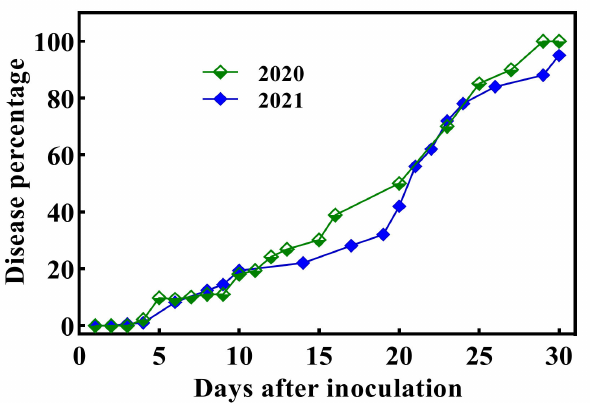
Figure 3. Dynamics of wheat canopy disease variation at different days after inoculation in both wheat growing seasons (2020 and 2021).